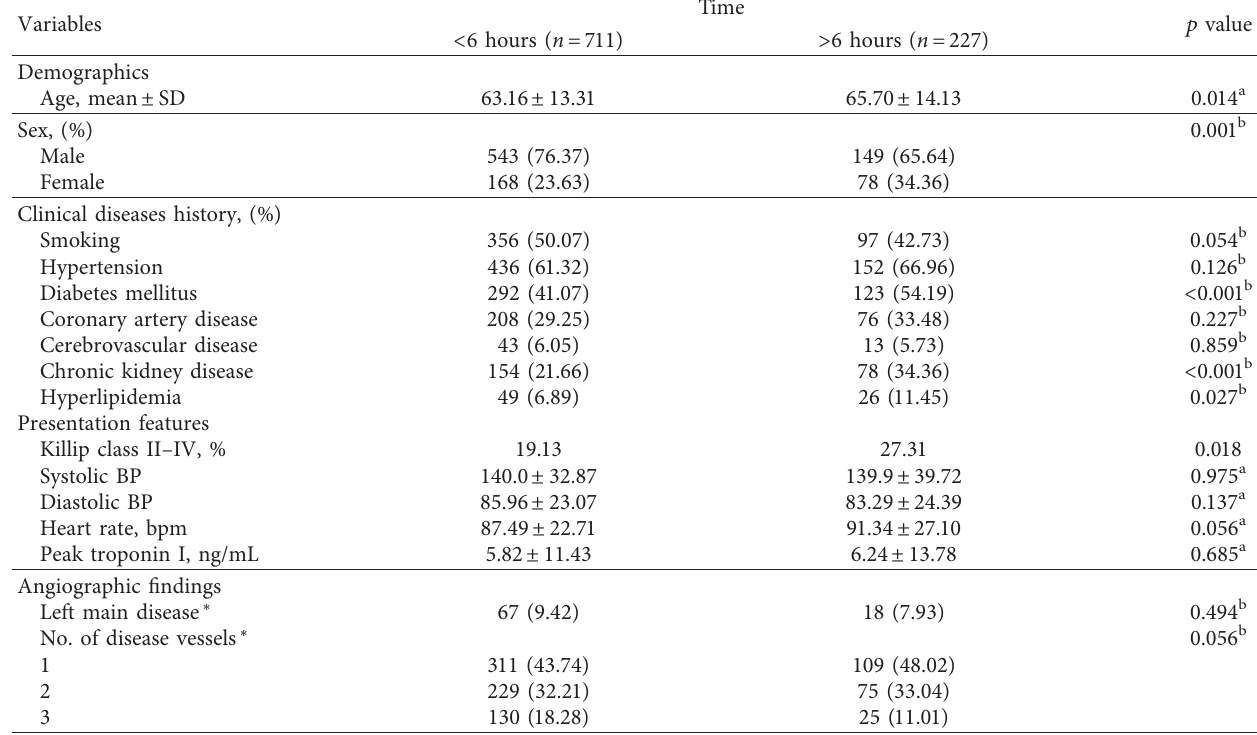
Table 1: Patient